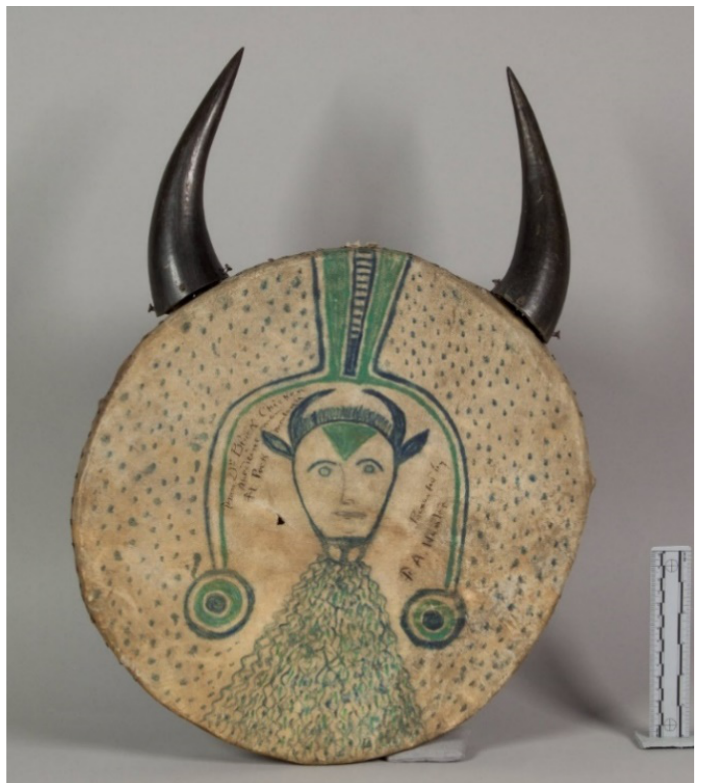
Figure 3. Hand Drum, Siyosapa (Hunkpapa/Yanktonai). Collected at Fort Peck, Montana in the 1890s. Wood, hide, nails, paint, 39.4 cm × 39 cm × 6.4 cm. Used by permission of the National Museum of Natural History (E360130).